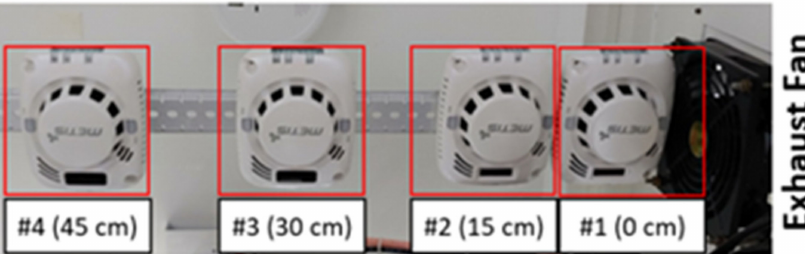
Figure 10. Location of a smoke detector which has been positioned around the exhaust fan for an